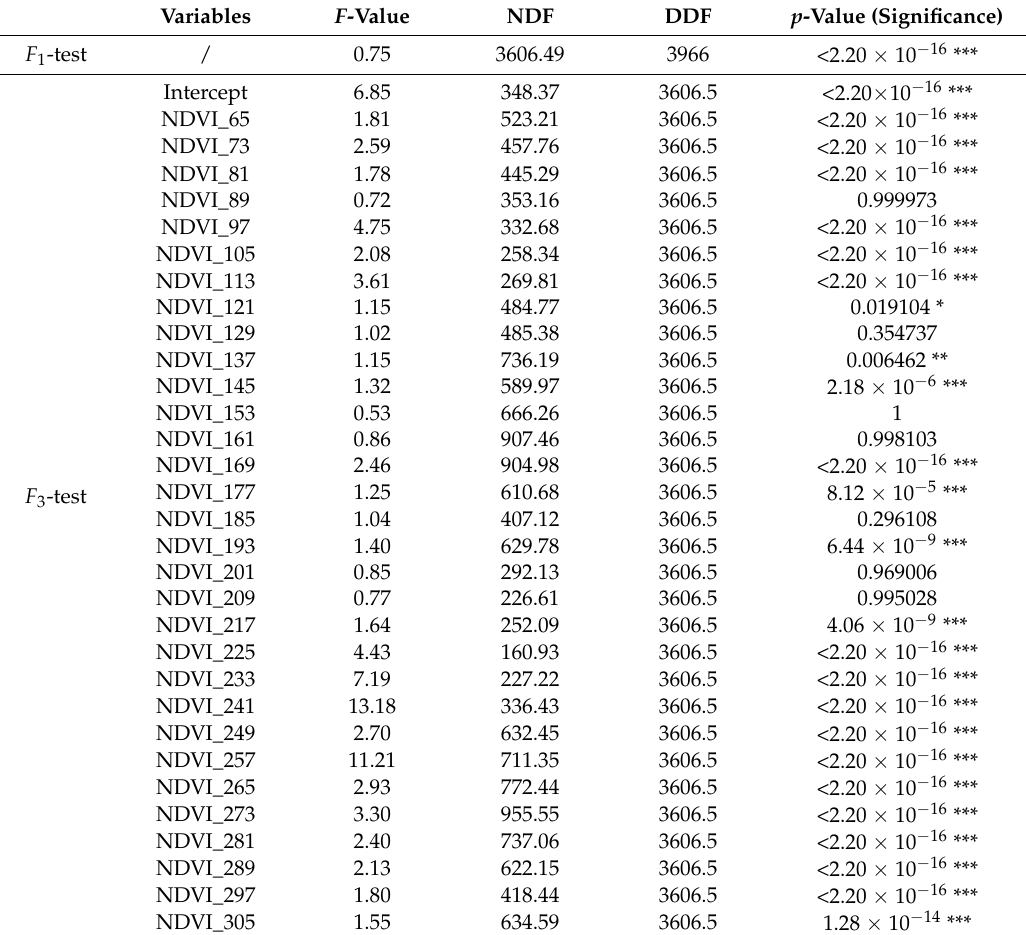
Table 2. Statistics of non-stationarity F -test between GWR and OLS model.